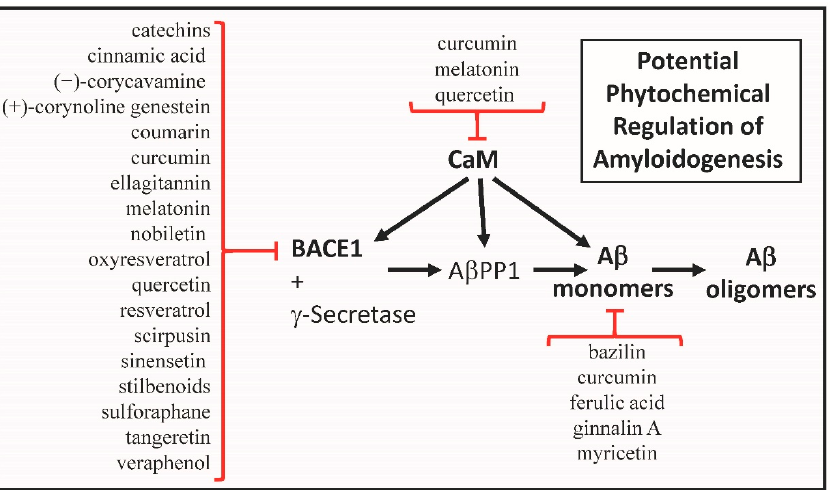
Figure 4. Phytochemical regulation of amyloidogenesis via calmodulin (CaM) and calmodulin binding proteins (bold).